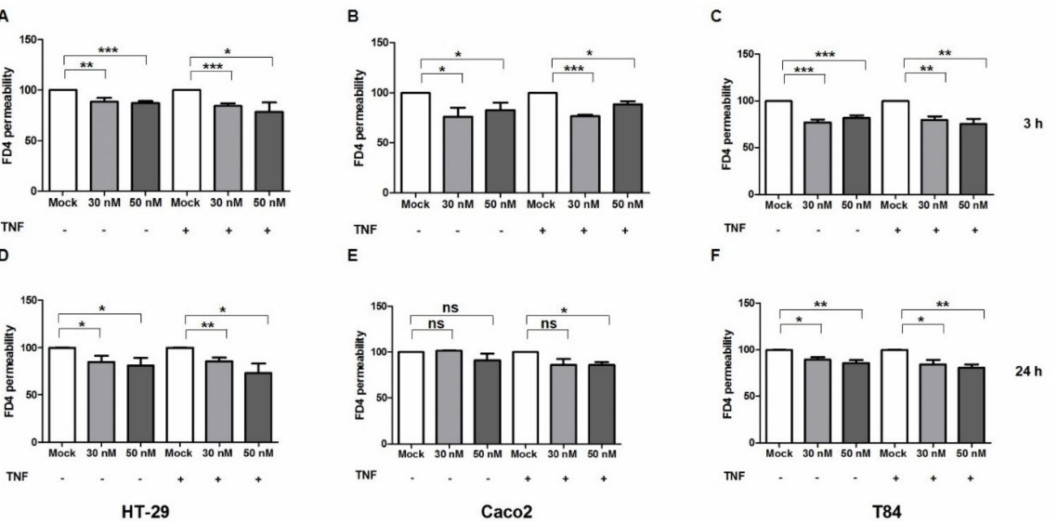
Figure 5. miR-195-5p regulates in vitro intestinal permeability. An increased dextran flux was observed after miR-195-5p mimic transfection in the HT-29, Caco2 and T84 cell lines with and without TNF- α stimulation at 3 h ( A – C ) and 24 h ( D – F ). Data are representative of four independent experiments. The histograms correspond to mean ± SEM. * p < 0.05; ** p < 0.01; *** p < 0.001. ns: not significant.